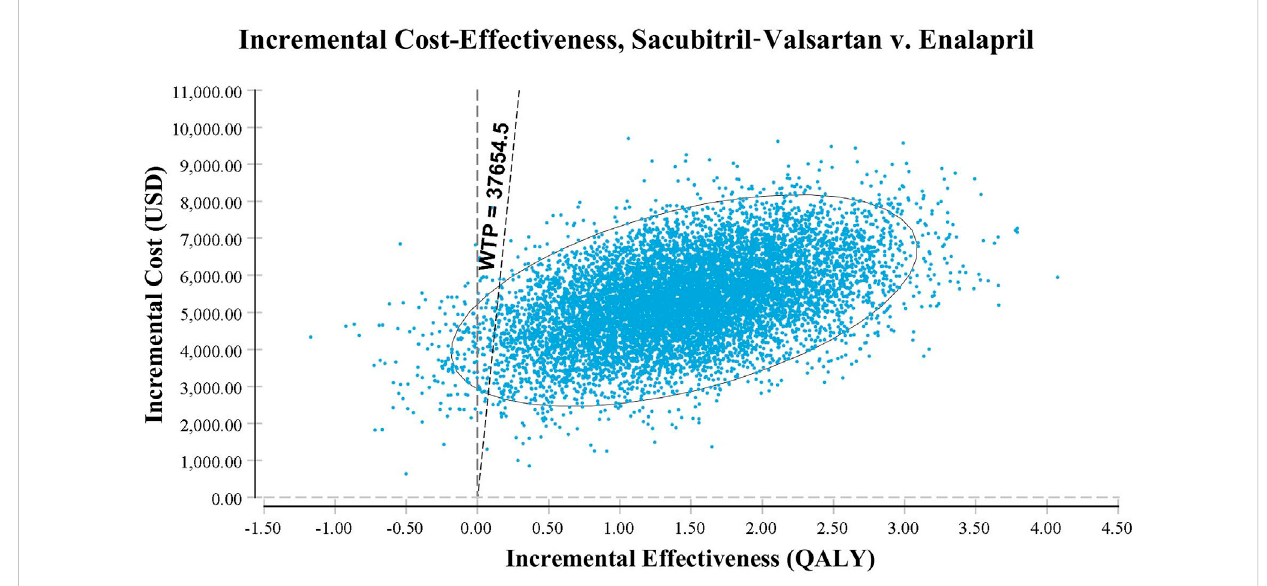
FIGURE 4 Scatter plot based on probabilistic sensitivity analysis. The probability that sacubitril – valsartan is cost-effective or superior to enalapril is over 97%.